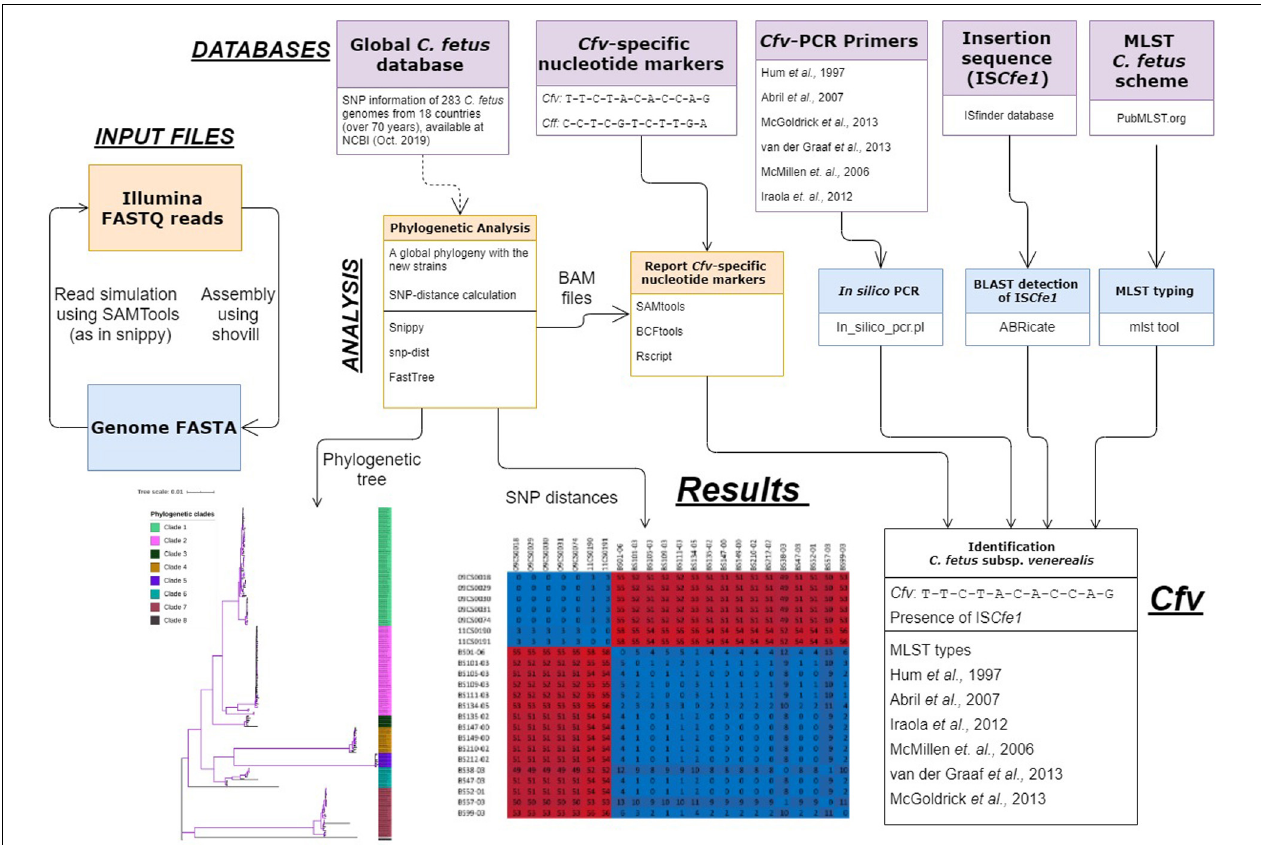
FIGURE 4 | An overview of the cfvCatch workflow to identify the Campylobacter fetus subsp. venerealis ( Cfv ) strains.